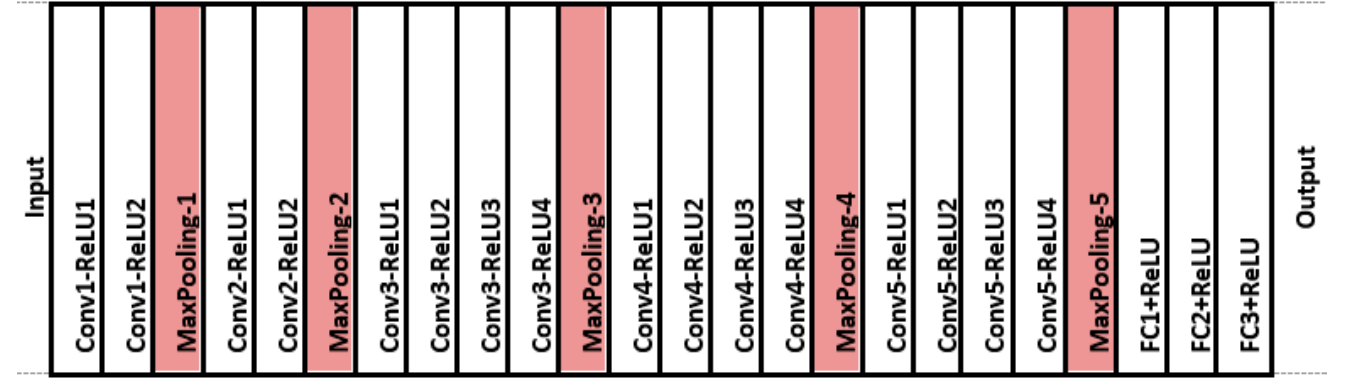
Figure 10. Architecture of VGG 19.